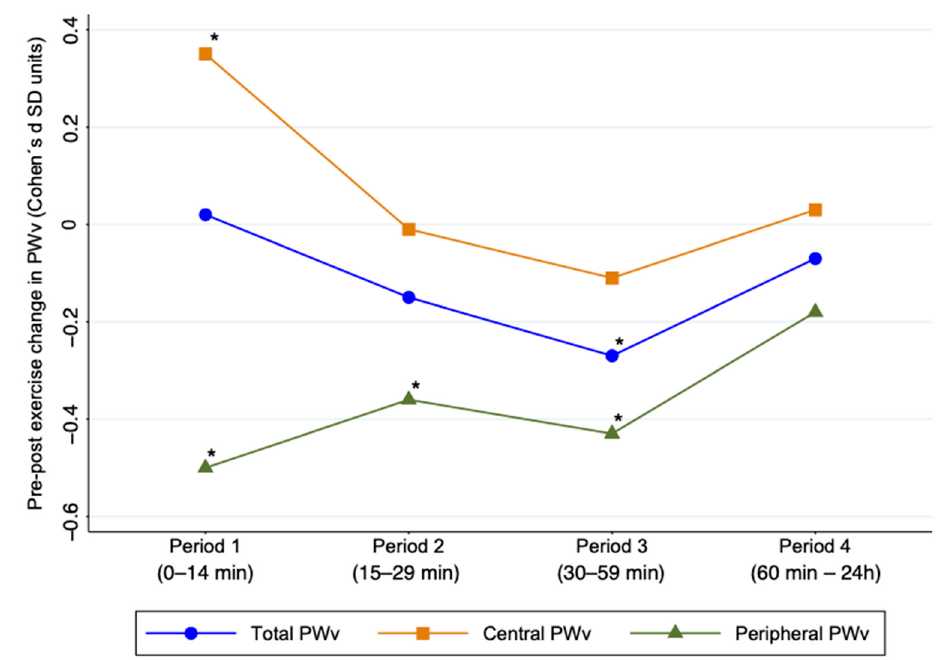
Figure 2. Acute effect of exercise on pulse wave velocity by time period after exercise. PWv: pulse wave velocity; SD: standard deviation * Values p < 0.05 were considered significant.